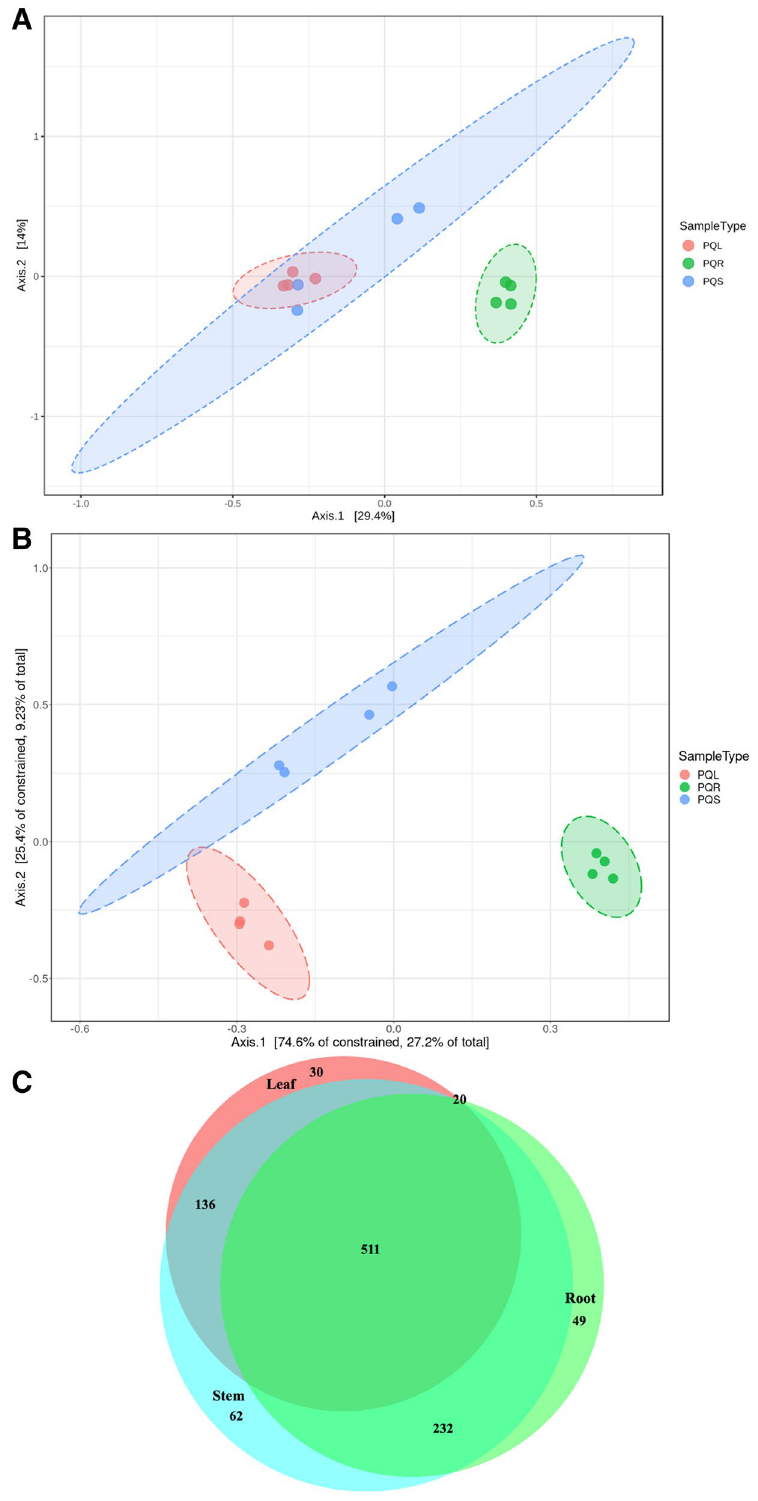
Figure 4. Beta diversity in Panax quinquefolius tissues ( A ) Principle coordinates analysis (PCoA) based on Bray–Curtis Index ( B ) Distance-based redundancy analysis (dbRDA) based on Bray–Curtis Index and constrained by tissue type ( C ) Venn diagram demonstrating the proportions of unique and overlapping operational taxonomic units (OTUs) between the different tissues. Venn diagrams were created using BioVenn online tool (http:// www. biove nn. nl). PQL, PQR, and PQS refer to Panax quinquefolius leaf, root and stem,